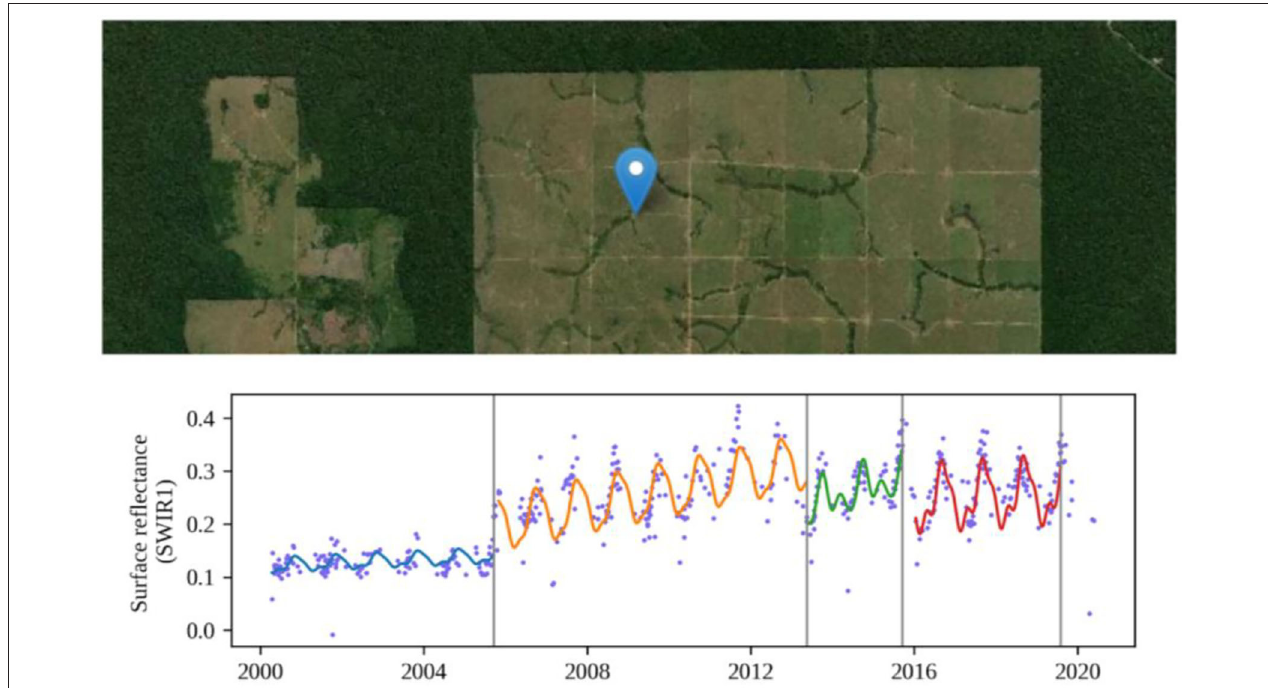
FIGURE 2 | Time series for a pixel of Landsat observations (blue dots) for the SWIR1 band, and the corresponding time segments detected by the CCDC algorithm. Each shift of a time segment to the next depicts a detected change in the surface and can be characterized either as a change in land cover, land use, or land condition. This example from Rondônia, in Brazil, depicts a stable primary forest converted to agriculture circa 2006, and captures recurrent seasonal patterns of agricultural cycles that persist until